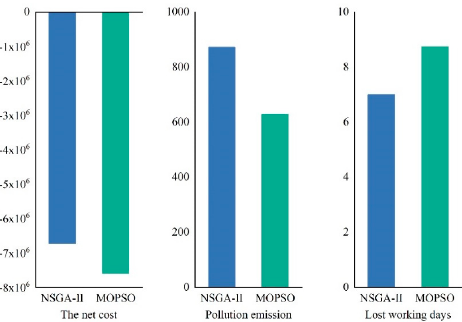
Figure 5. The value of objective functions based on two of meta − heuristic algorithms.